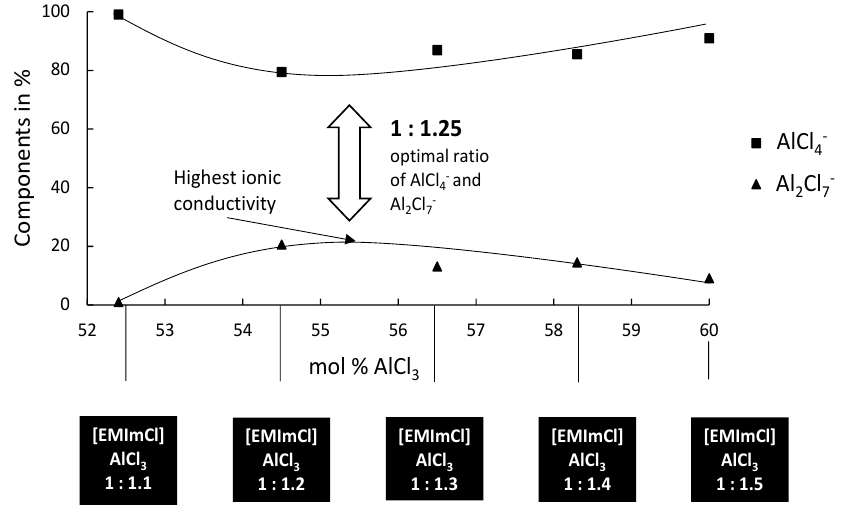
Figure 1. Different molar ratios of [EMIm]Cl:AlCl 3 with the active species, represented by the NMR study by Ferrara et al. [34].